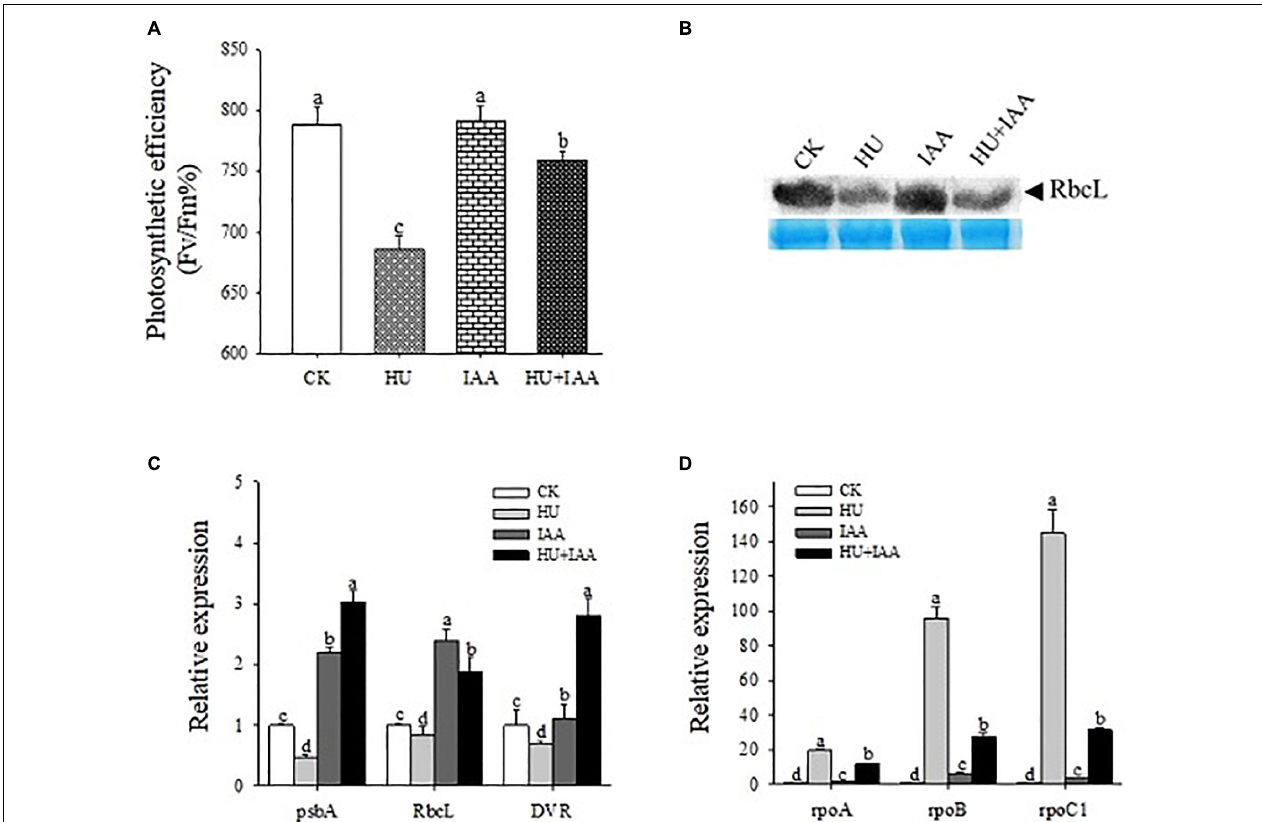
FIGURE 2 | The IAA-treated rice plant’s photosynthesis performance under HU stress. (A) Photosynthetic PSII efficiency in the leaves of plants treated with HU, IAA, and their combination ( n = 8). (B) Rubisco large subunit (RbcL) protein expression (top panel) and protein loading control were confirmed by Coomassie blue staining (bottom panel). (C,D) Transcript levels of plastid-nuclear genes involved in chlorophyll biosynthesis. Different letters indicate significant changes between treatments, tested by one-way ANOVA followed by Fisher’s test ( n = 3, p < 0.05). CK, Control; HU, Hydroxyurea; IAA, indole-3-acetic acid.